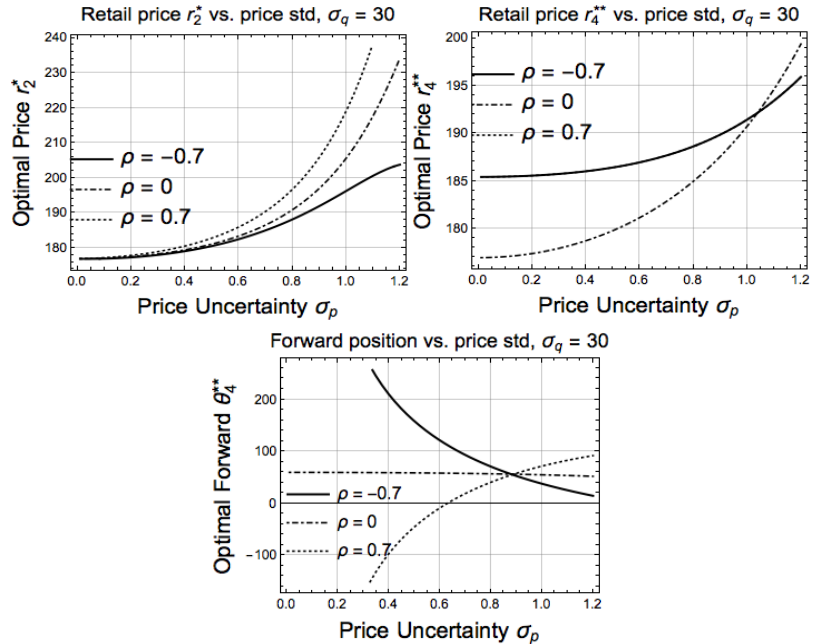
Figure 10. Comparison of r ∗ from Theorem 2 and r ∗∗ and θ ∗∗ from Theorem 4 as a function of price volatility σ p under a small ( ρ = − 0.7), medium ( ρ = 0), and large ( ρ = 0.7) correlation.